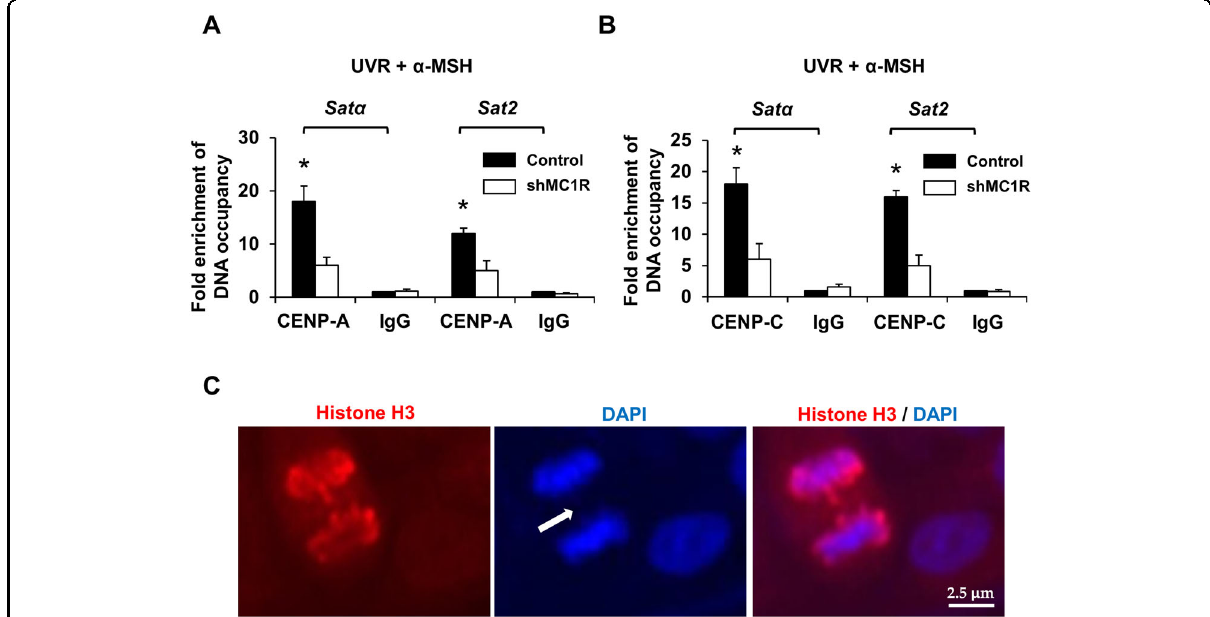
Fig. 2 Lack of MC1R disrupts CENP-A/C binding to centromeric and pericentric DNAs. ChIP assays were performed to determine the binding of CENP-A ( A ) and CENP-C ( B ) to centromeric ( Sat α ) and pericentric ( Sat2 ) DNAs in HPMs/shControl or HPMs/shMC1R, with the Ideal ChIP-seq kit (Diagenode). Anti-CENP-A, anti-CENP-C, or control IgG was used for each IP. After completion of the ChIP, samples were diluted 1:100 in ddH 2 O for qPCR. Sat α and Sat2 DNAs were ampli fi ed. The value in IgG group was set as “ 1 ” . * p < 0.01, n = 3, Student ’ s t test. C An anaphase HPMs with shMC1R showing lagging chromosome formation (arrow). The nuclei were stained with DAPI (blue).